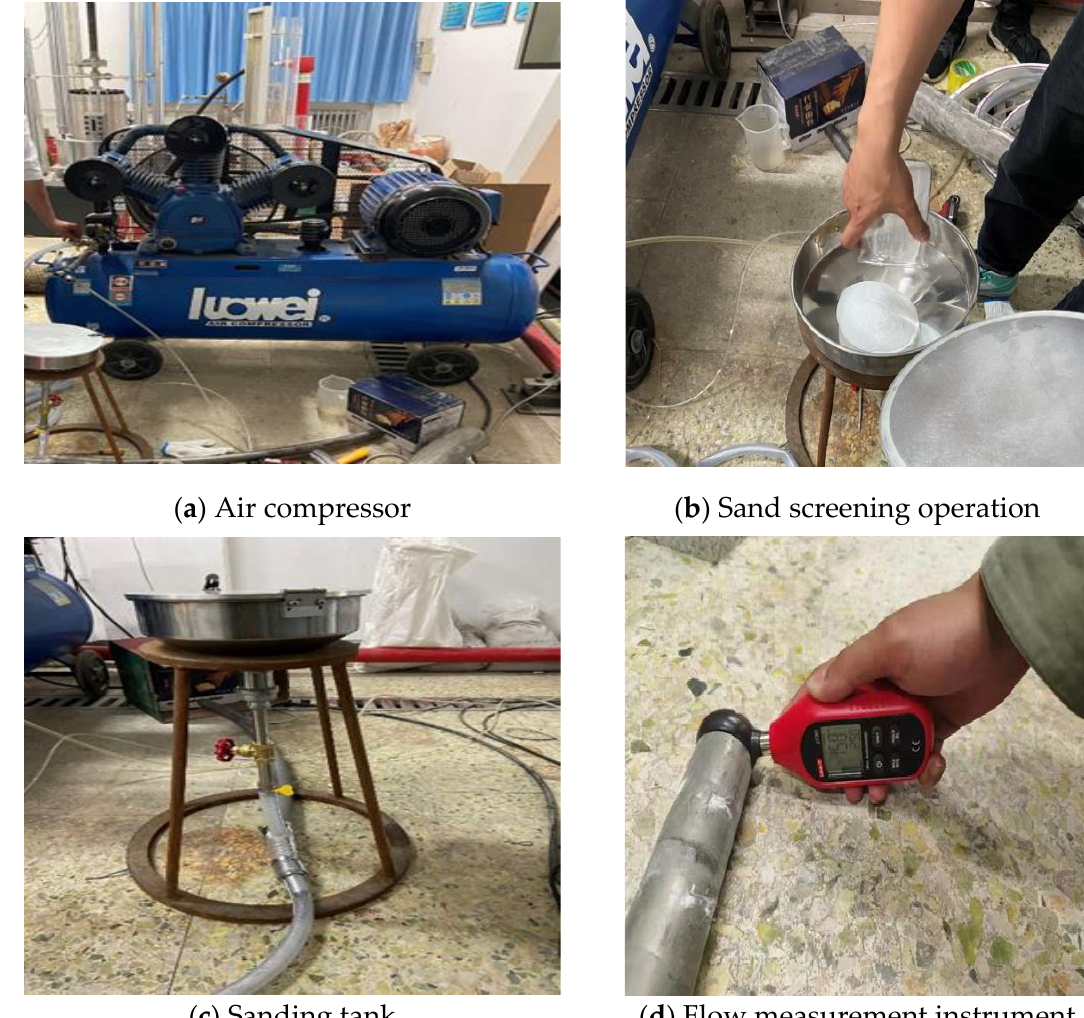
Figure 2. Photos of the experimental device.